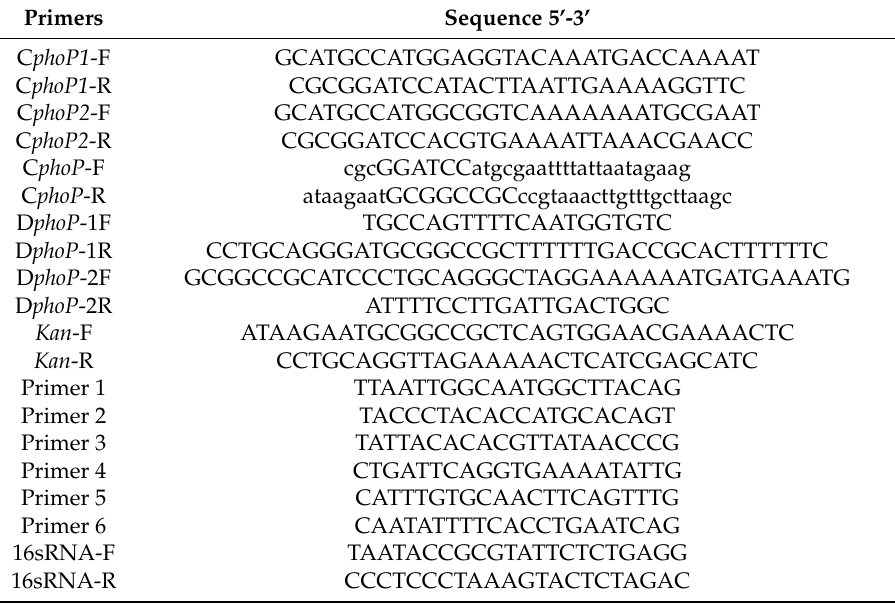
Table 5. Primers used in the